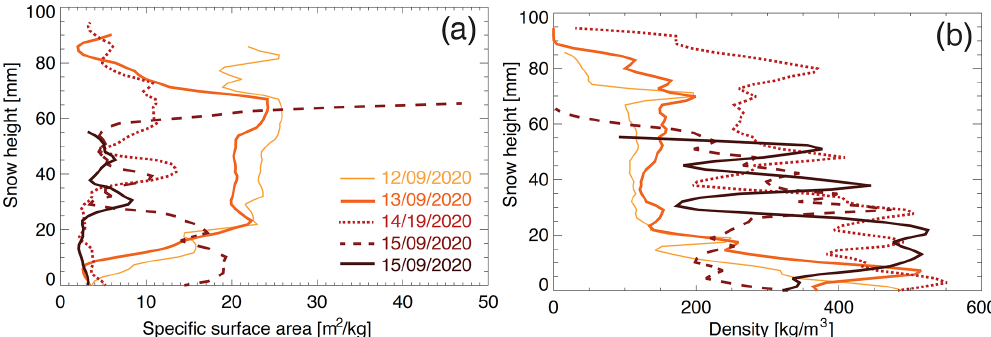
Figure A2. Profiles of specific surface area (SSA) (a) and density (b) before, during, and after the rain-on-snow event. The bottom of the sample is represented by 0. Please note that the bottom of the sample is not necessarily the snow–ice interface, as discussed in Fig. 4 in the main paper.